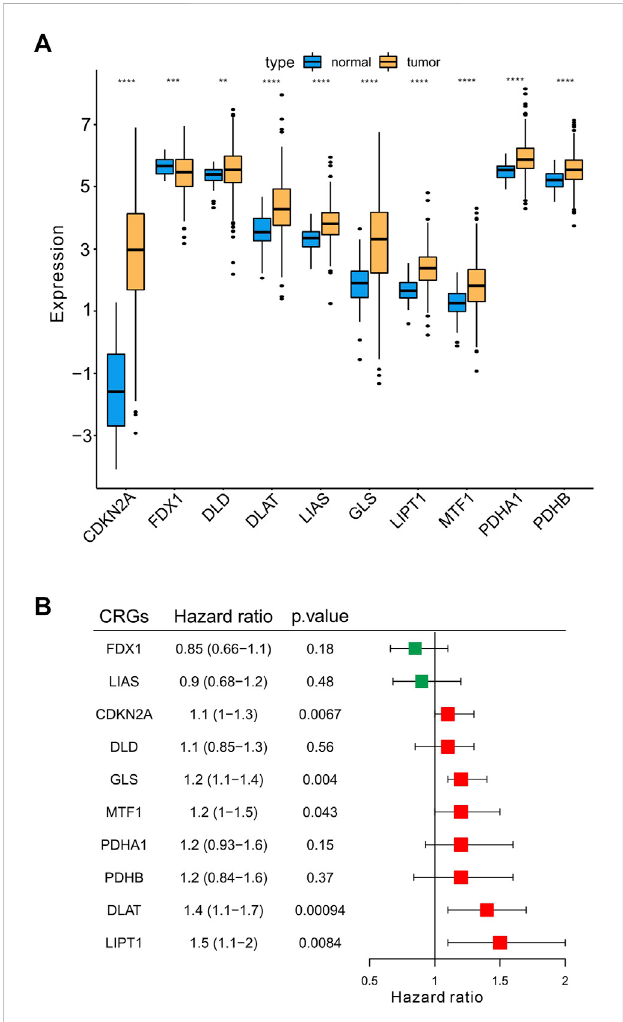
FIGURE 3 Determination the differentially expressed CRGs and prognostic signatures in HCC. (A) The expression of 10 CRGs in HCC ( n = 368) and normal liver tissues ( n = 50) in TCGA-LIHC cohort. Tumor was shown in orange, while normal liver was shown in blue ( t -test, * p < .05; ** p < .01; *** p < .001; **** p < .0001; ns, not statistically signi fi cant). (B) Univariate Cox regression analysis of CRGs. The right boxplots represented the Hazard ratio with 95% con fi dence interval, the p -value was calculated by univariate cox